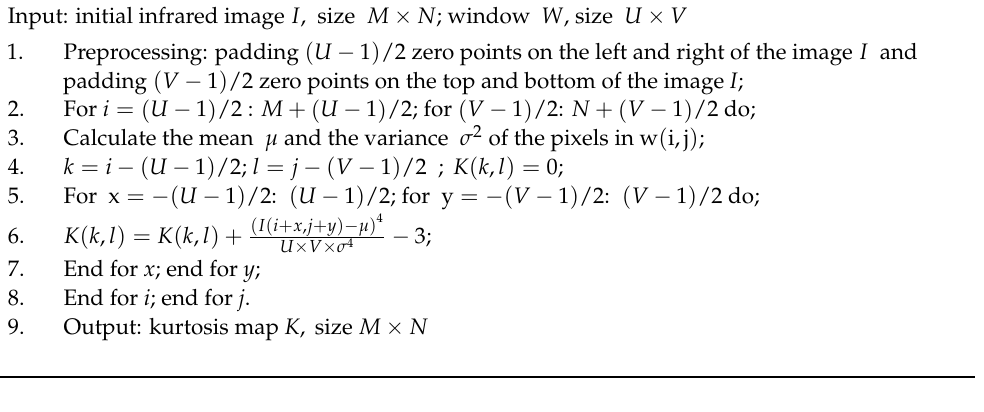
Algorithm 1 The Computational Steps of the Kurtosis Map